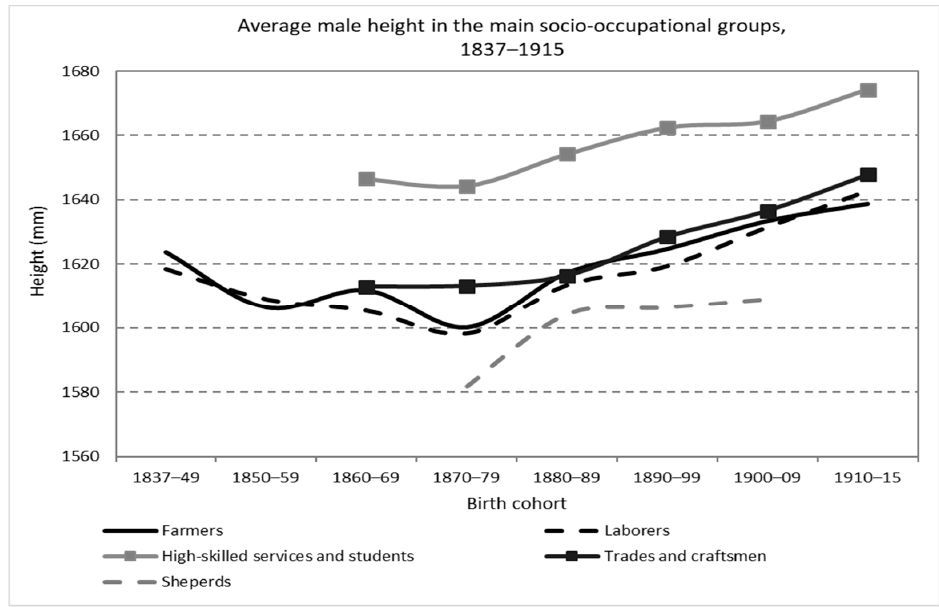
Figure 4. Average male height in the main socio-occupational groups, birth cohorts 1837–1915 (Source: calculated with data from the Expedientes